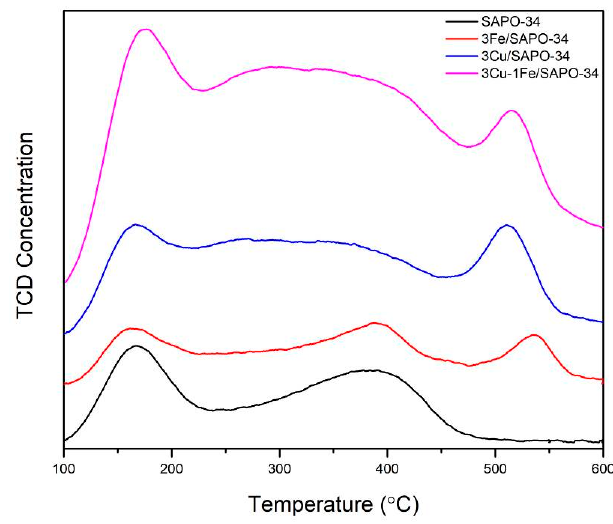
Figure 4. Temperature-programmed desorption of ammonia as-synthesized samples.